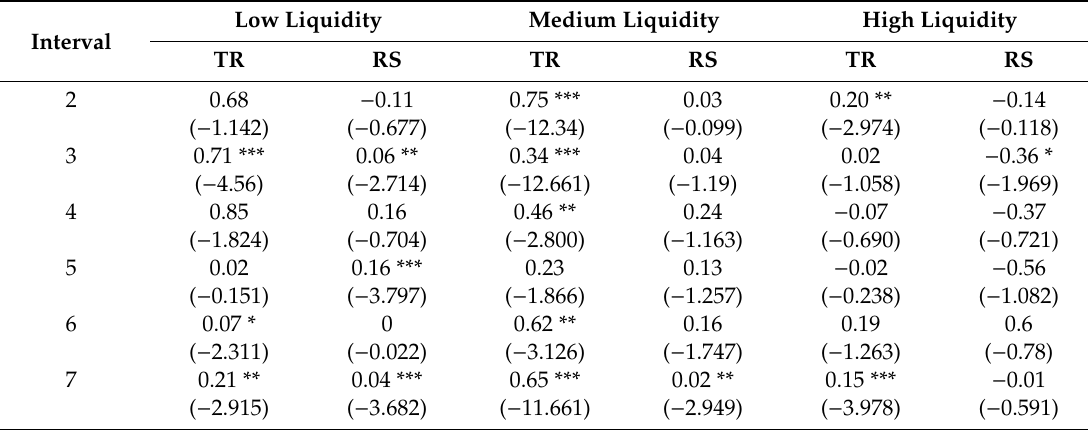
Table 4. Relation between Abnormal Returns and Liquidity Measurement. Dummy Variable (DV): Liquidity prior to